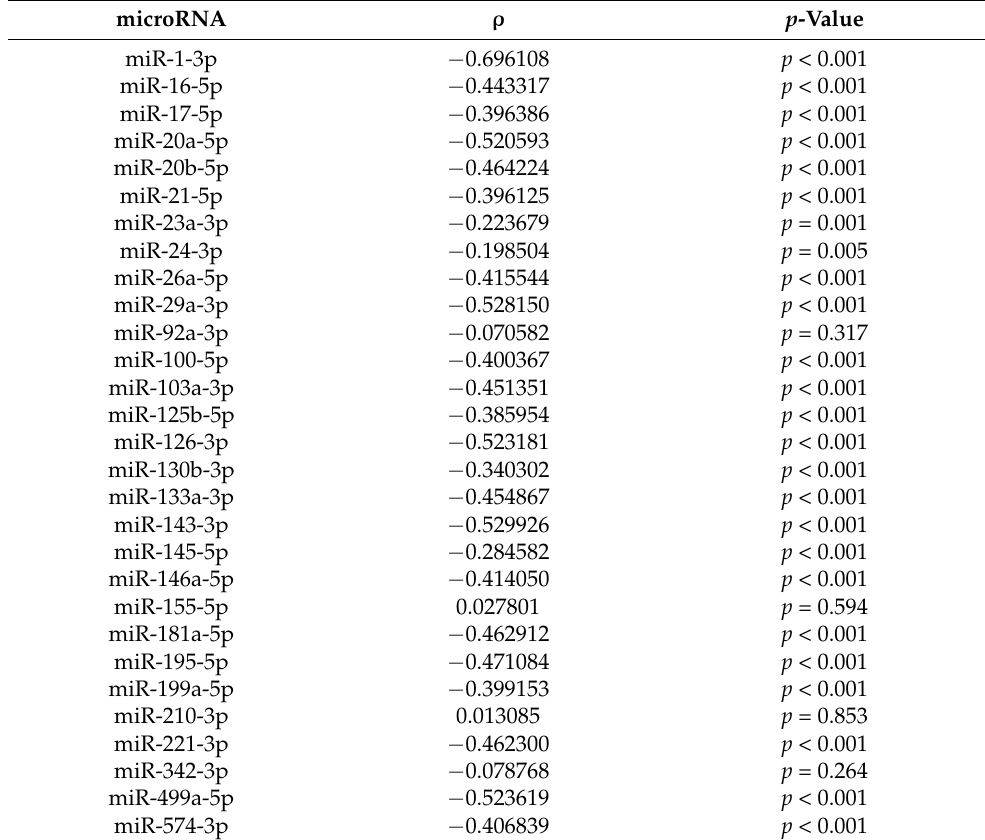
Table 4. Postnatal increase in microRNA gene expression with descending birth weight of